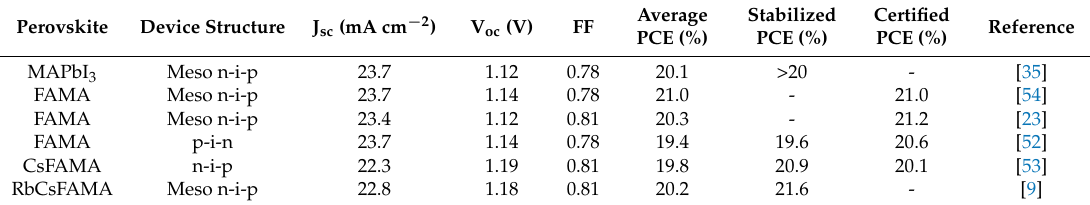
Table 1. Parameters for solar cells (measured at 1 sun-AM1.5G) based on record-efficient perovskite solar cells (adopting various n- or p-type contacts and under various cell structures). J sc , V oc and FF values are taken from the best device, reported in every reference.